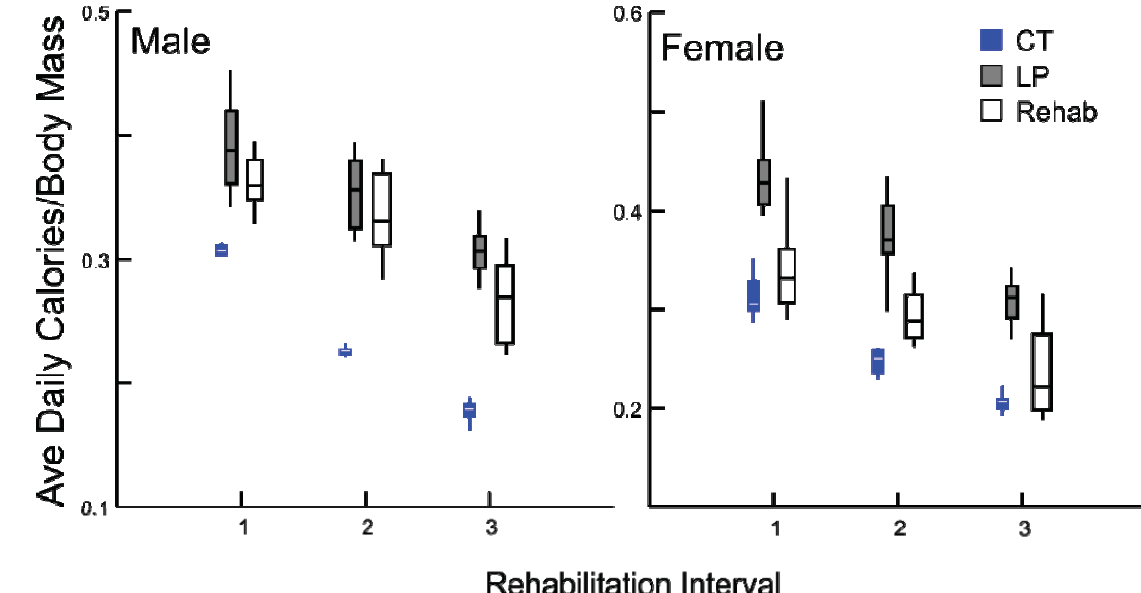
Figure 6. Box plots, illustrating daily average calorie consumption (kCal/day) by body mass (g) for chronic CT, LP and rehabilitation animals for 10 days following diet alteration. Rehabilitation intervals encompass the following durations: 1 = animals aged 40–49 days, 2 = 60–69 days, and 3 = 90–99 days (all comparisons p (cid:2) 0.001, except between LP and rehabilitated